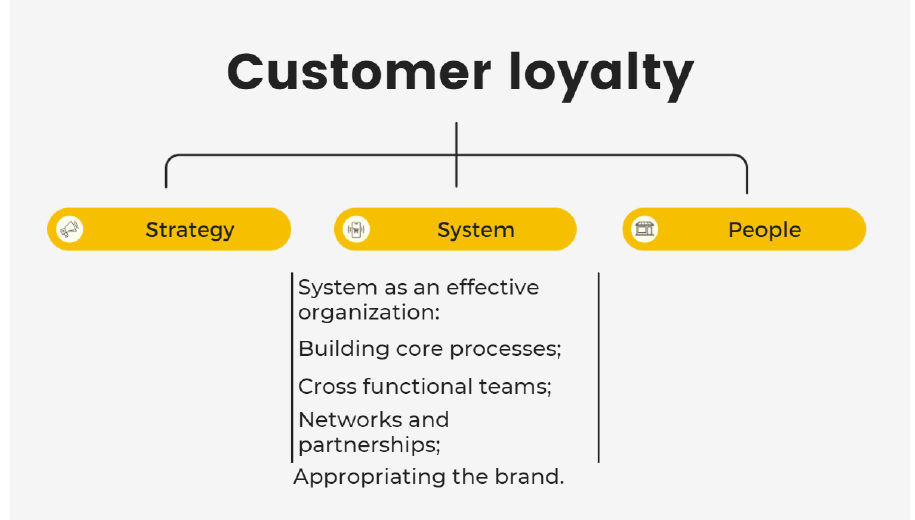
Figure 10. Market-led innovation: systems